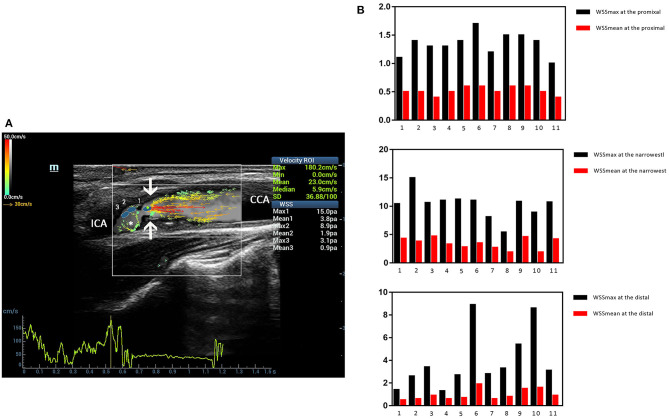
Severe carotid stenosis. V flow imaging shows very high-velocity flow (red vectors) at the narrowest region (arrows) and vortex at the distal of the stenosis (asterisk) (A). Wall shear stress (WSS) point-by-point measurements show a high maximum WSS (WSSmax) value of 15.0 Pa at the narrowest region (blue dot 1 on A) (B). CCA indicates common carotid artery, and ICA indicates internal carotid artery.